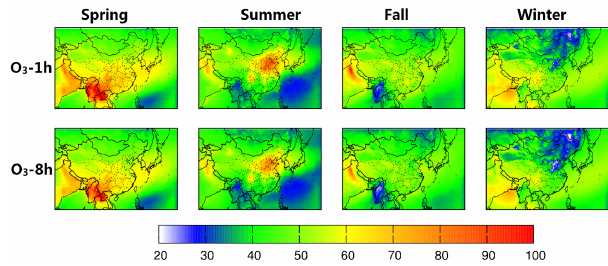
Figure 5. Seasonal variations of predicted regional distribution of O 3 -1h and O 3 -8h. Units areppb.